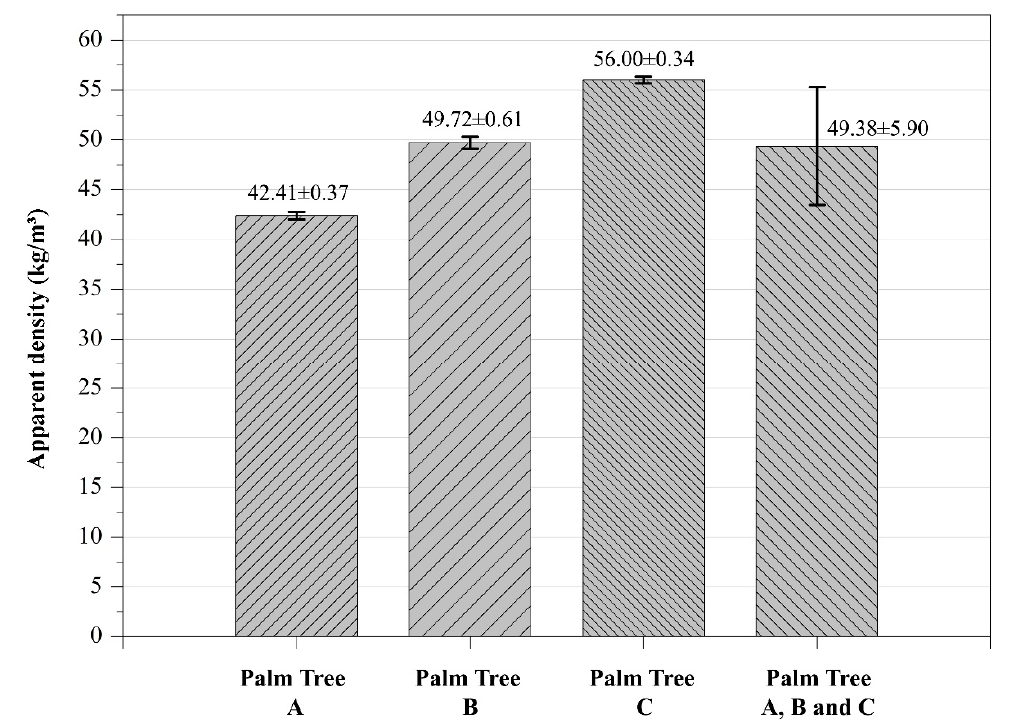
Figure 8. Apparent density of Buriti foam.